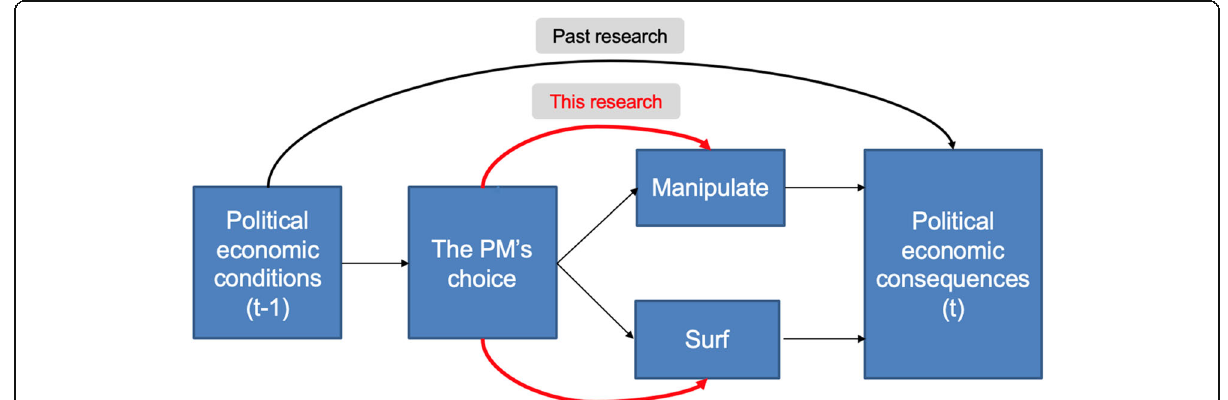
Fig. 1 Diagram of previous studies and the current